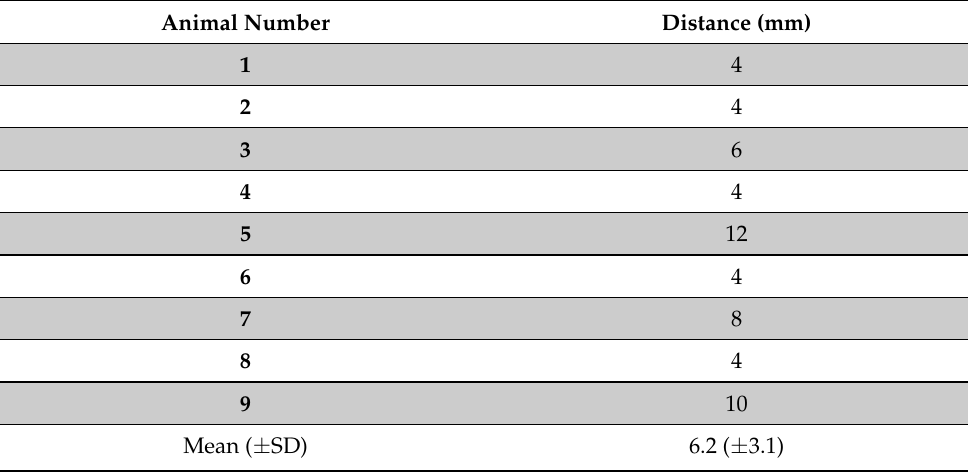
Table 2. Measured distance between both origins of the common carotid arteries (SD ± 3.1